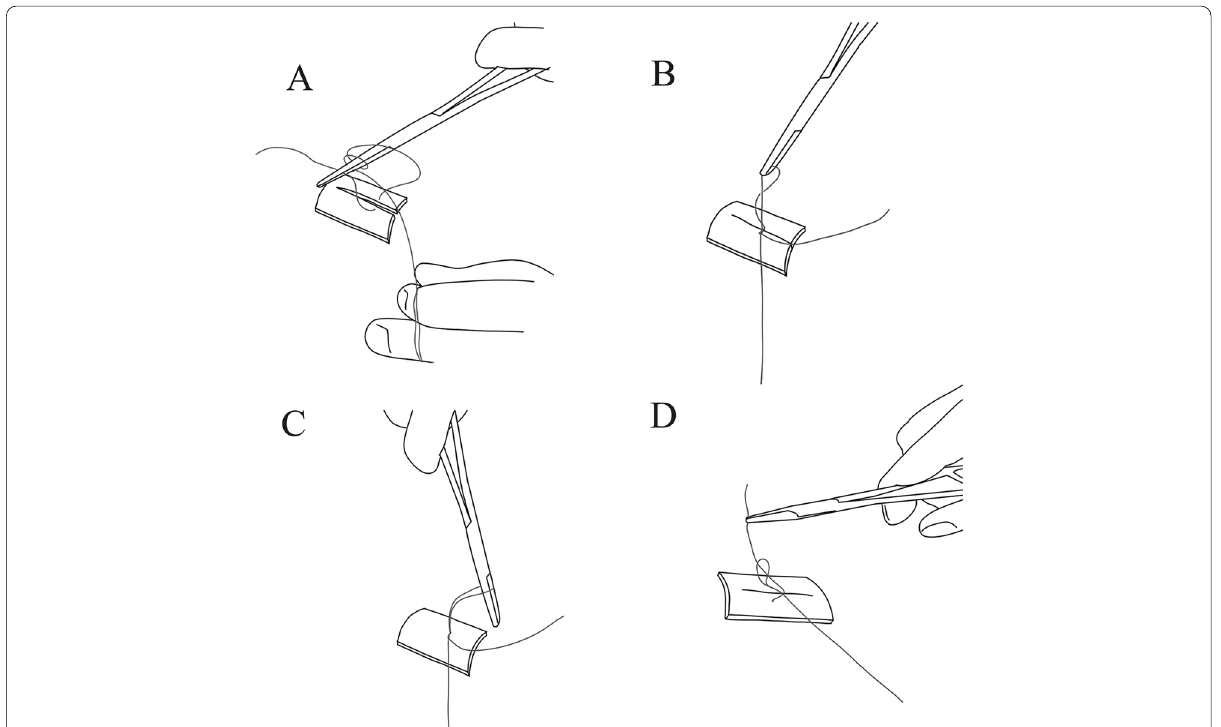
Fig. 1 Schematic view of the new suturing technique. A The free end of the suture should be wrapped around the needle holder twice. B The middle of the short end of the suture is grasped by the needle holder. C The short end of the suture is passed through the loop not completely to make a bow tie. D The needle holder is passed through the bow tie to grasp the free end of the suture and pull it over to complete the knot. This procedure is repeated one more